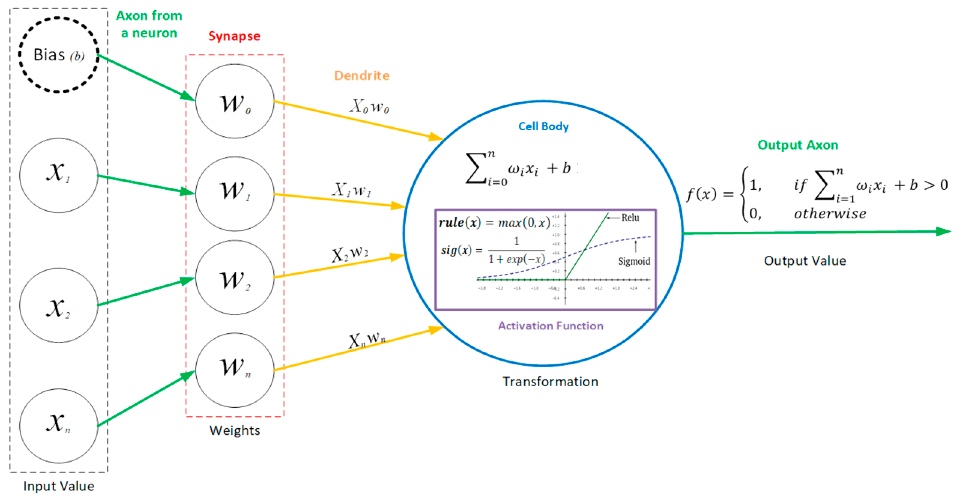
Figure 4. Structure of a single neuron.